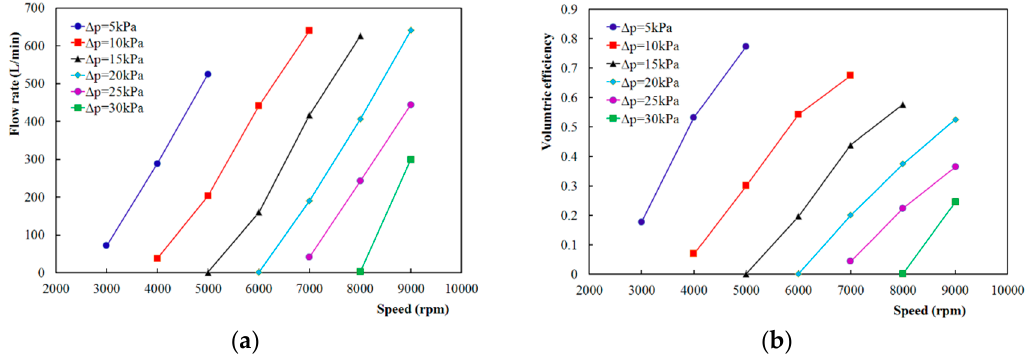
Figure 5. Effect of pressure difference on the performance: ( a ) flow rate; and ( b ) volumetric efficiency.